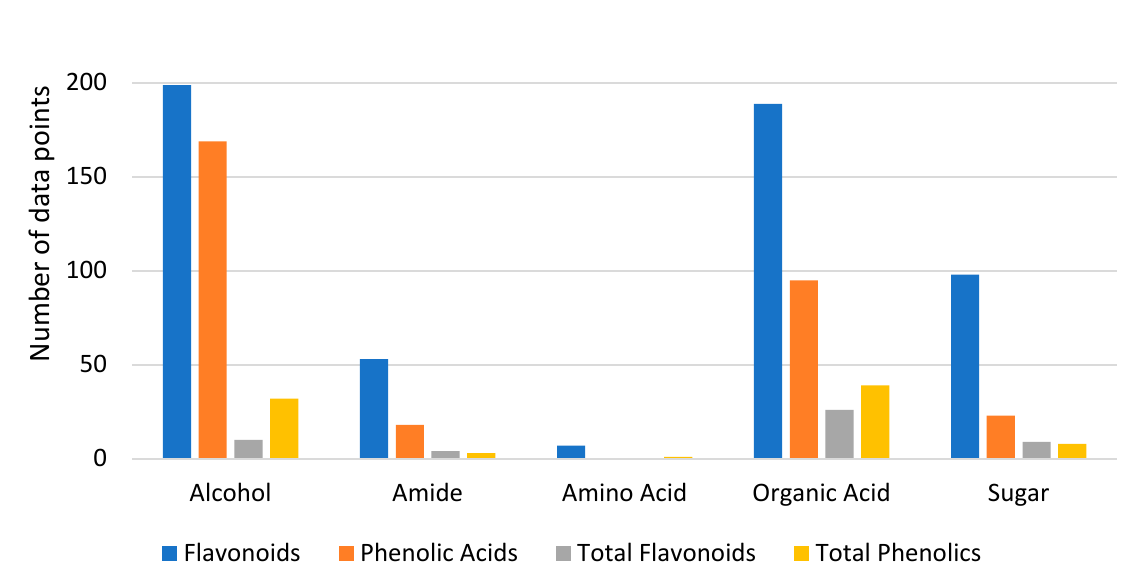
Figure 6. Distribution of the different compounds extracted, grouped by the functional group of the HBD and the nature of the phenolic extracted.